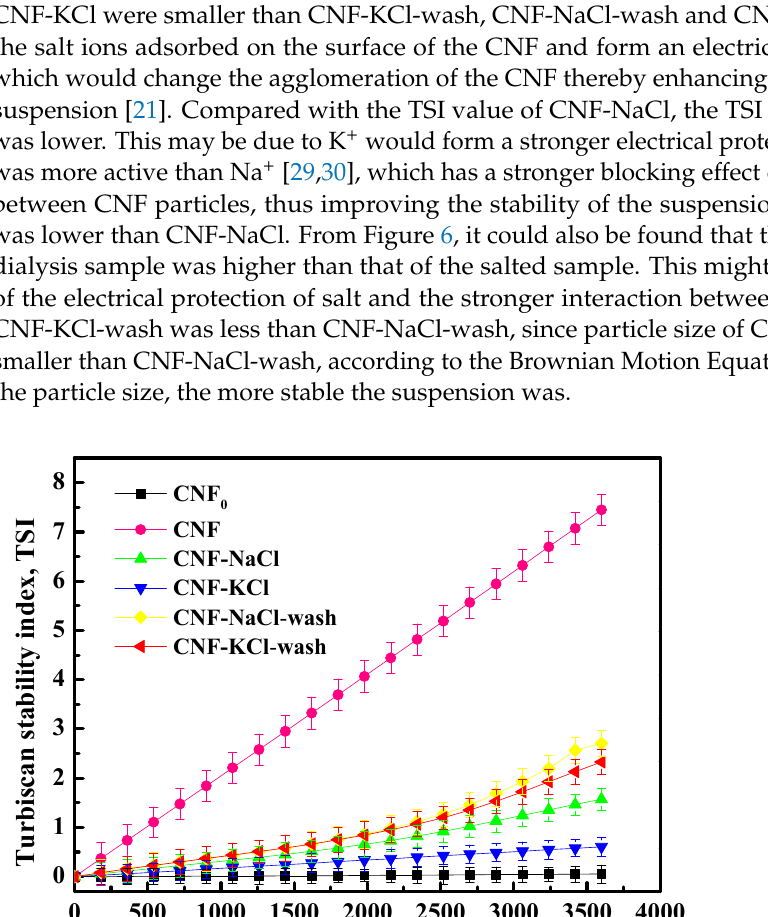
Table 2. Dispersion index of